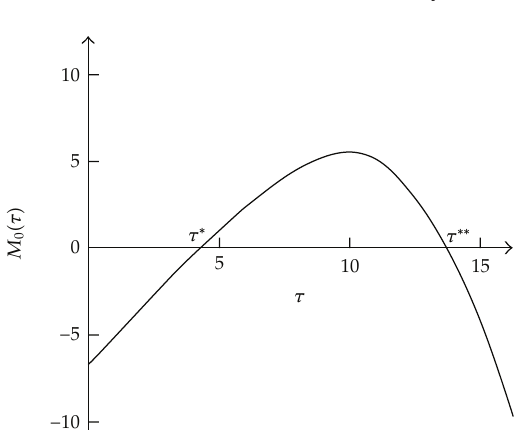
Figure 1: The graph of the function M 0 (cid:4) τ (cid:5) . Two critical values of τ (cid:4) i.e., τ ∗ and τ ∗∗ (cid:5) , for which stability switches can occur,